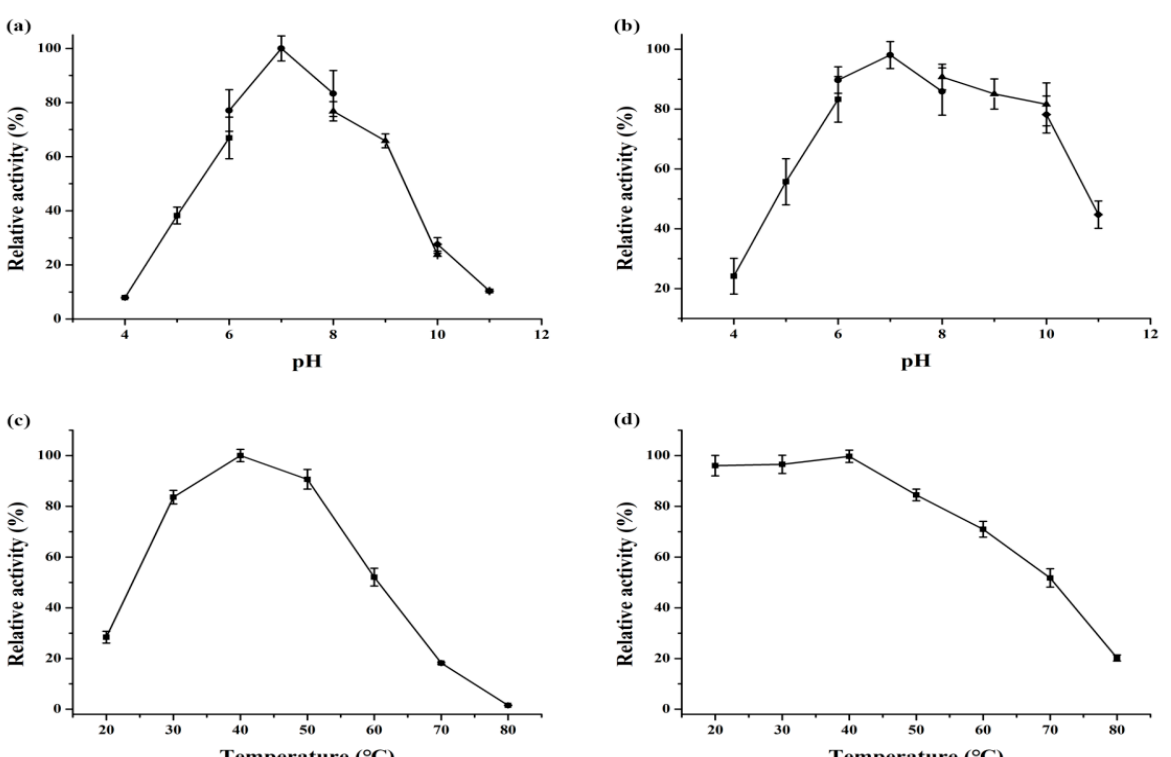
Figure 3. Effects of pH and temperature on fibrinolytic activity and stability. ( a ) The optimum pH of Velefibrinase was determined at a pH range of 3.0 to 13.0. The maximum activity was observed at pH 7.0 and was considered to be 100%. ( b ) After incubation for 24 h, the residual protease activity was measured to investigate the pH stability of Velefibrinase. The enzyme activity before incubation was regarded as 100%. ( c ) The optimum temperature of Velefibrinase was estimated at a temperature range of 20–80 ◦ C. The maximum activity was obtained at 40 ◦ C and was considered to be 100%. ( d ) The thermal stability of Velefibrinase was evaluated after incubation in 0.02 M PBS (pH 7.0) at various temperatures for 24 h.